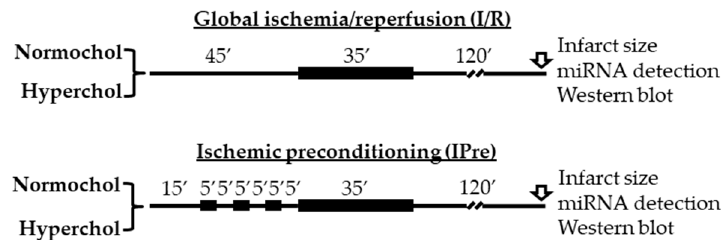
Figure 5. Experimental protocols for ex vivo ischemia / reperfusion (IR) and IR with ischemic preconditioning (IPre). At the end of reperfusion infarct size, miRNA expression analyses and Western blotting measurements were performed from the left ventricles. Normochol and Hyperchol refer to normo- and hypercholesterolemia, respectively.